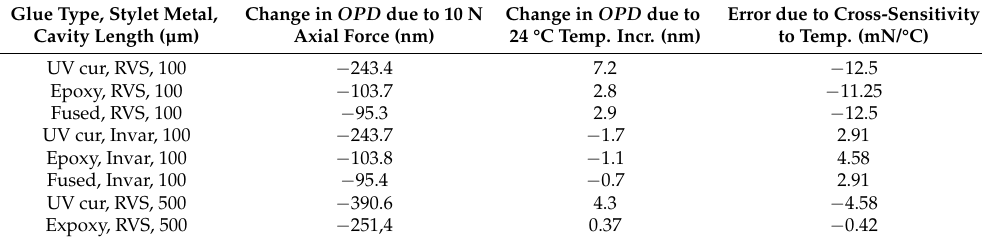
Table 1. Results of the FE-analyse of the sensitivity of the FPI of the quartz capillary concept to force and temperature. The first column shows the type bond used to fix the optical fiber in the ferrule (UV curable NOA 68, epoxy EPO-TEK 353ND or fused glass), the material used for the stylet tube and needle tip and the cavity length. The second column shows the change in geometrical cavity length ( OPD ) due to application of a 10 N load on the needle tip. The third column shows the change in cavity length ( OPD ) as a response to an increase in temperature of 24 °C, accounting for the CTE of materials used in the needle tip and the thermo-optic coefficient of air. The last column shows the expected measurement error due to cross-sensitivity to temperature in